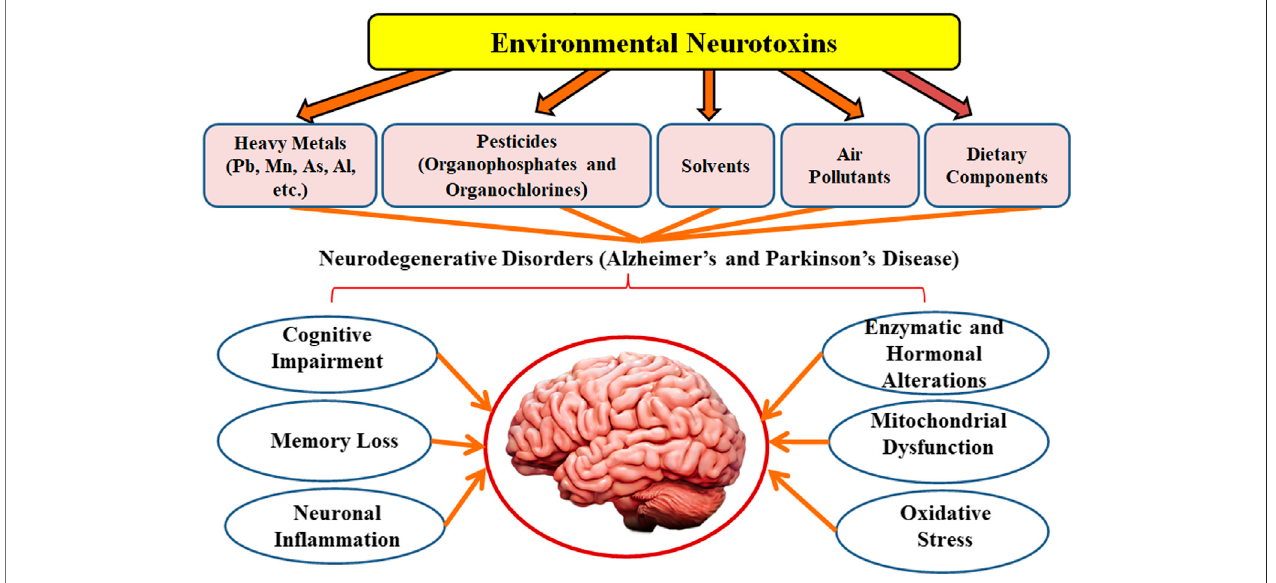
FIGURE 1 | The impact of environmental toxicants on neurodegenerative